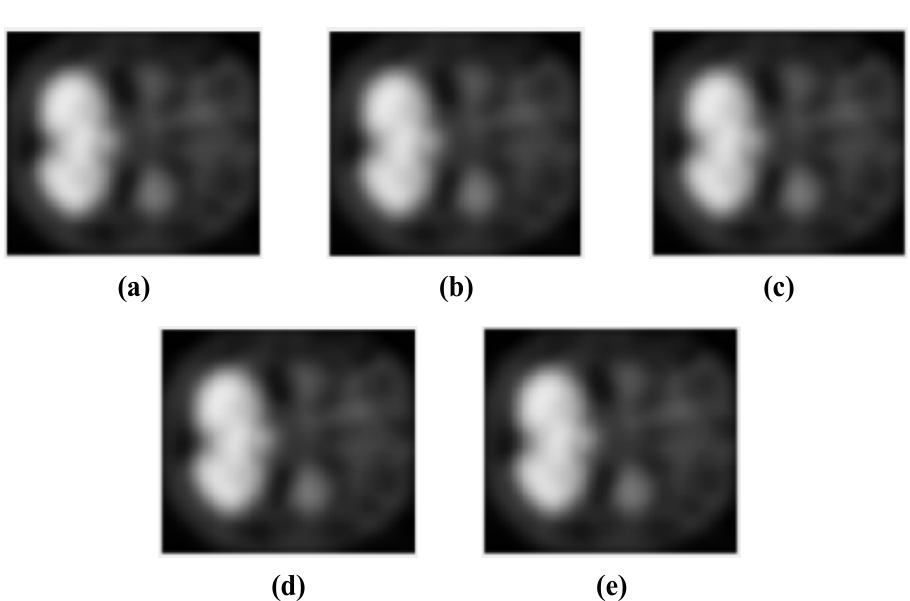
Figure 2. Filtered images used for simulations in our study for binary and multiclass classification of AD: ( a ) reference image belonging to AD class without filtering; ( b ) box-filtered image belonging to AD class with SSIM = 0.9921; ( c ) modified Gaussian-filtered image belonging to AD class with SSIM = 0.9971; ( d ) Gaussian-filtered image belonging to AD class with SSIM = 0.9992; ( e ) median- filtered image belonging to AD class with SSIM = 0.9952.